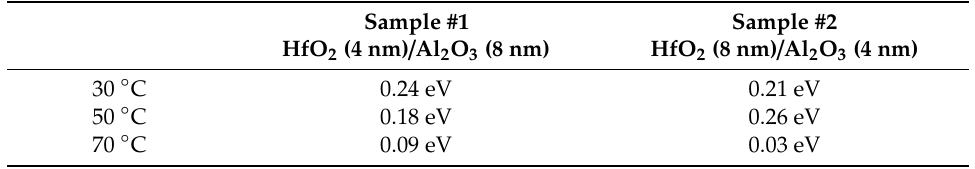
Figure 5. Fowler–Nordheim (F–N) tunneling plots for the MOS-capacitors. ( a ) Sample #1 with HfO 2 (4 nm)/Al 2 O 3 (8 nm) laminated dielectrics, ( b ) Sample #2 with HfO 2 (8 nm)/Al 2 O 3 (4 nm) laminated dielectrics. Table 3. Extracted barrier height from the F–N leakage mechanism.